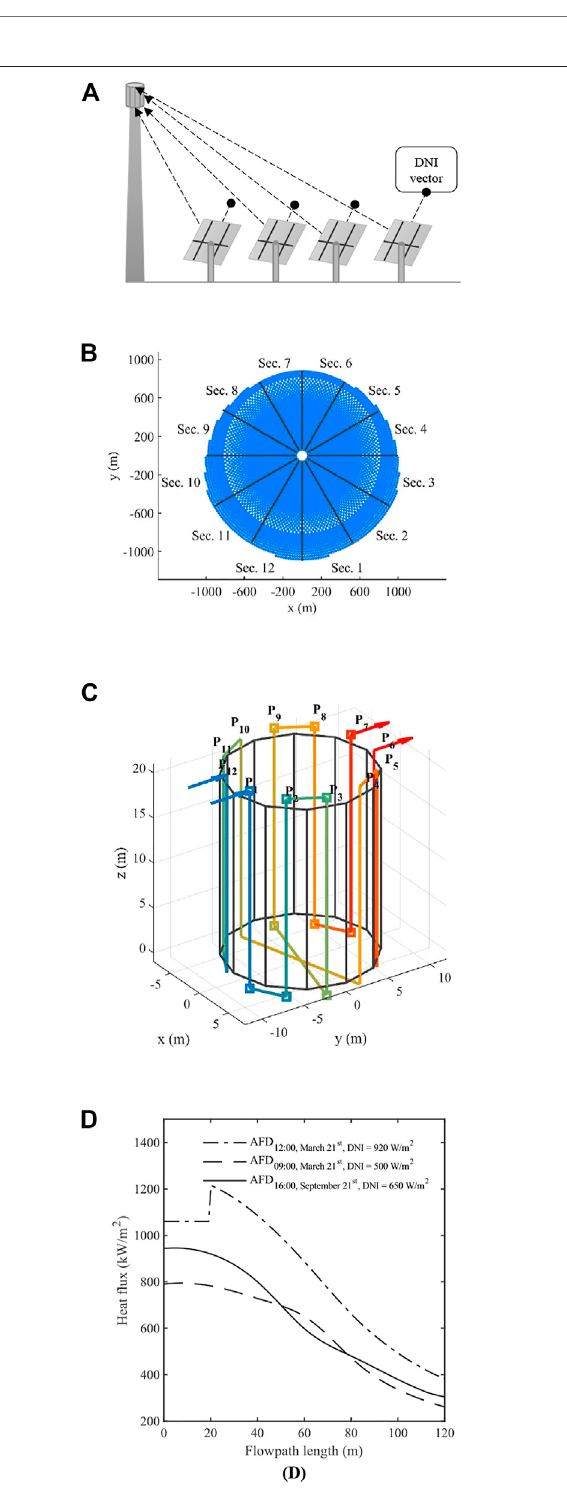
FIGURE 2 | (A) Scheme of solar radiation re fl ected from the heliostat fi eld toward the receiver (B) Solar fi eld layout. Adapted from (Flesch et al., 2017) (C) Flow paths within the studied receiver. The squared marked line represents fl ow path 1 going from panel 1 through 7 (D) AFD for the studied receiver at different times and